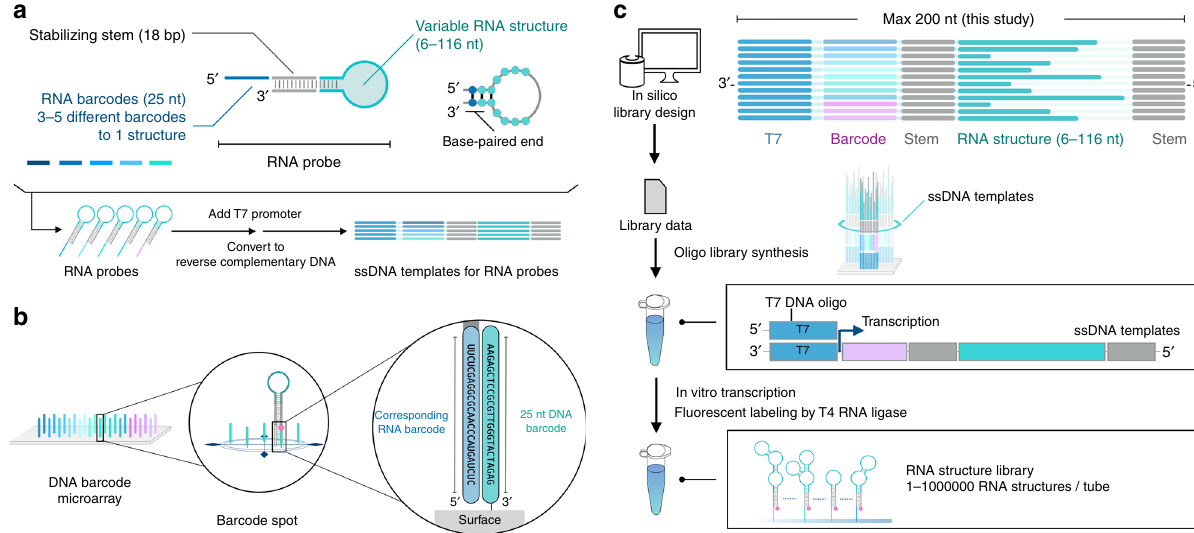
Fig. 3 RNA structure library for ligand interactions and DNA barcode microarray for quanti fi cation. a In silico molecular design for the RNA structure library. Extracted RNA structures are conjugated to the stabilizing stem structure and RNA barcodes for massively parallel quanti fi cation of each RNA in the library. After the addition of the T7 promoter sequence, reverse complementary DNA sequences are synthesized as an oligo pool. See also Supplementary Fig. 1 and Methods. b Schematic of the barcode-based hybridization on a custom DNA microarray. Each spot on the microarray contains DNA sequences complementary to one barcode region of the RNA probe in the library. c In vitro preparation of the RNA structure library. The single- stranded DNA (ssDNA) templates in the pool have anti-T7 promoter sequences that can hybridize to the T7 promoter ssDNA. In turn, the T7 polymerase produces the RNA structures in a single tube. In vitro transcription generates the library in a single tube from the oligo DNA pool. The subsequent RNA ligation attaches a fl uorescent dye to the 3 ′ end of the RNA probes for detection and quanti fi